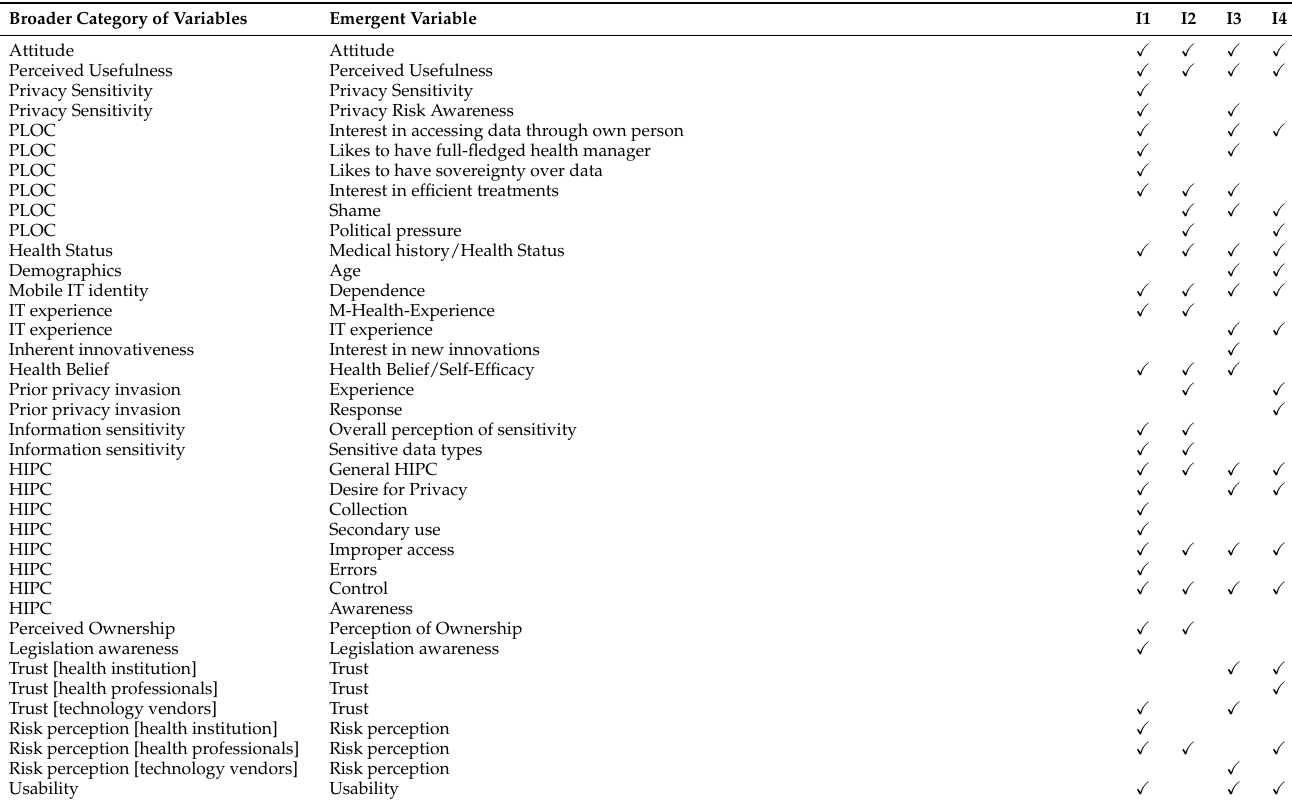
Table A3. Emergent Themes from the